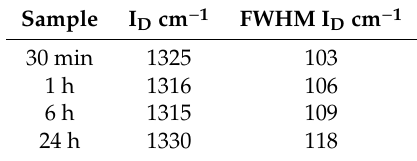
Table 2. Broadening of the D band of